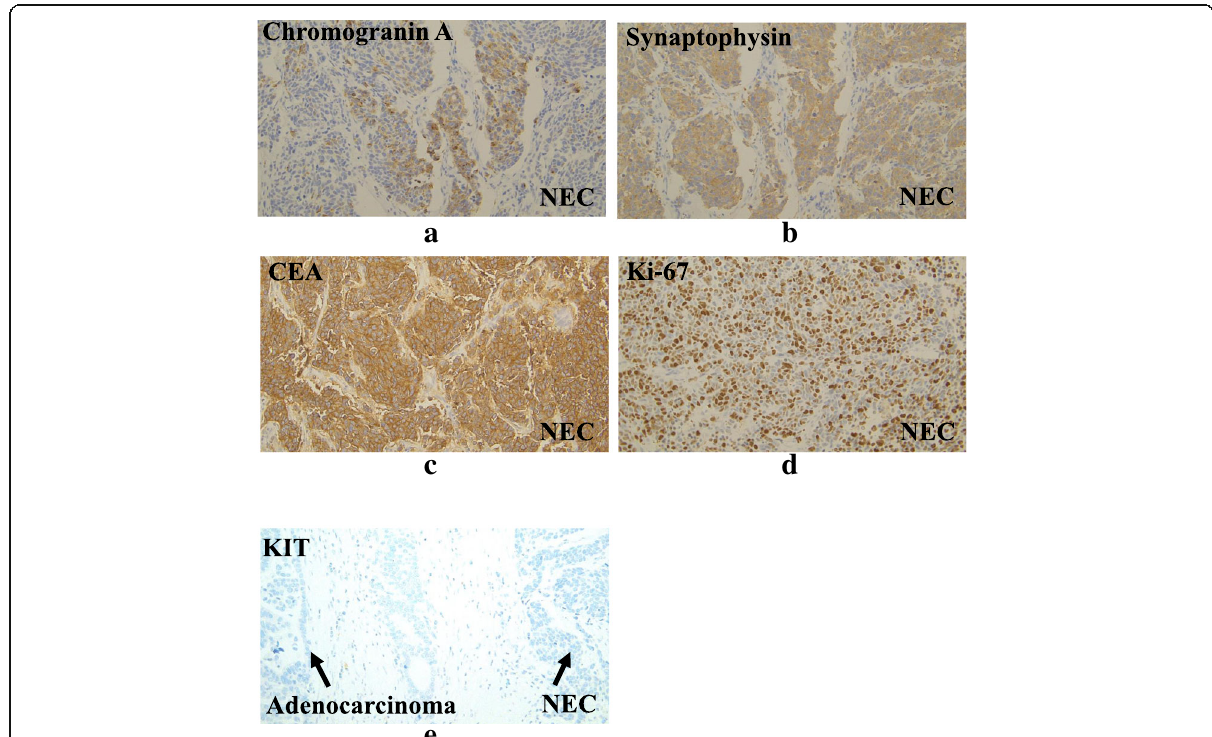
Fig. 7 Immunohistochemical staining of the NEC revealed positive staining for chromogranin A ( a ), synaptophysin ( b ), and CEA ( c ), and more than 90% of the nuclei were positive for Ki-67 ( d ). Neither the adenocarcinoma component, nor the NEC component showed positive staining for KIT ( e